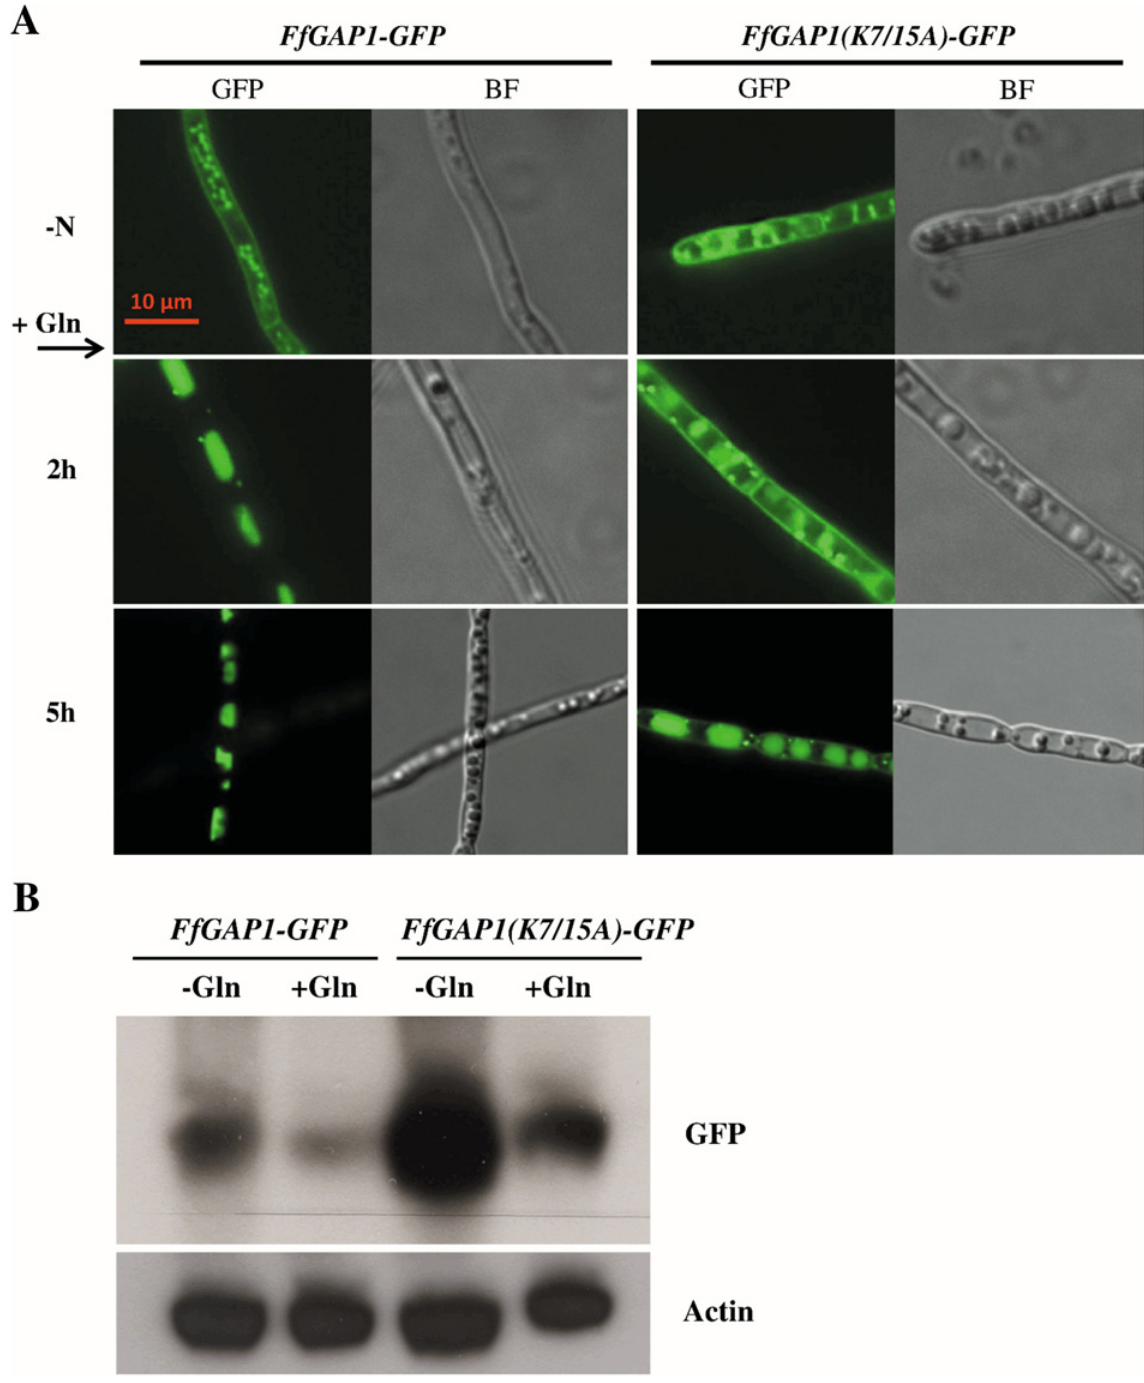
Fig 9. Conserved lysine residues influence sorting and protein stability of FfGap1. F . fujikuroi wild-type transformed with the FfGap1-Gfp or the FfGap1 (K7/15A)-Gfp fusion construct was cultivated in liquid ICI medium with 6 mM glutamine for 48 h. (A) Cells were observed by fluorescence (GFP) and brightfield microscopy (BF) before (- N) and 2 h and 5 h after addition of 12 mM glutamine (+ Gln). (B) Western blot analysis of protein extracts before (- N) and 2h after addition of 12 mM glutamine (+ Gln). Hybridization with an anti-actin (actin) antibody was used as protein loading control.